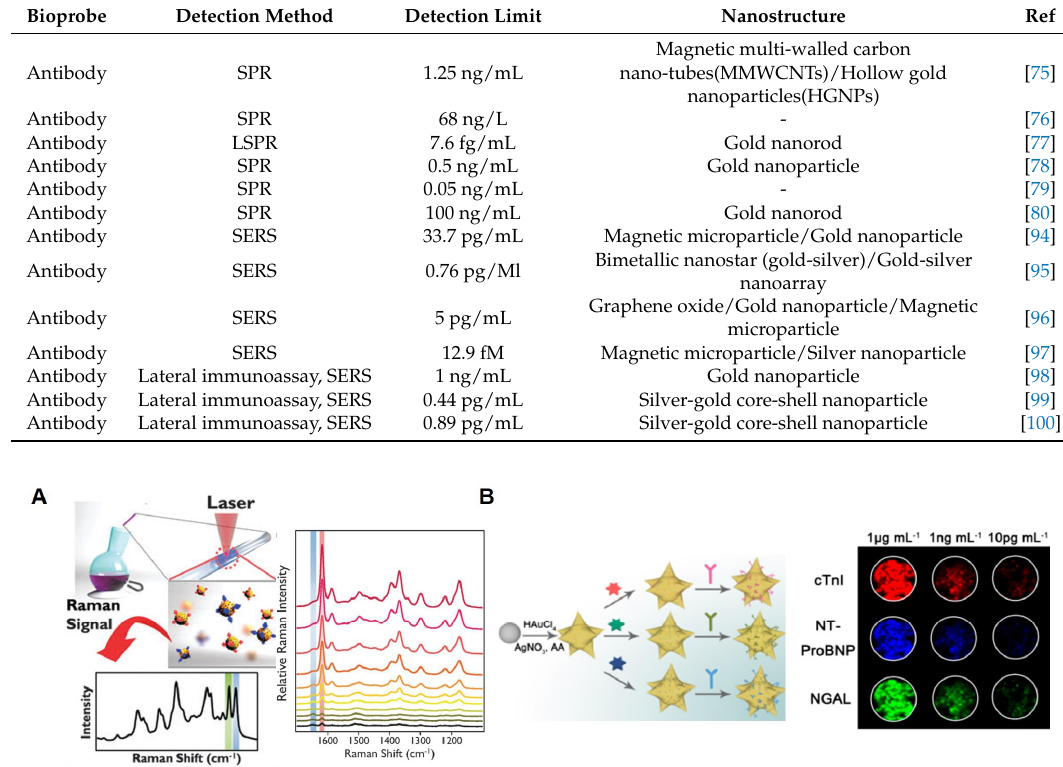
Figure 4. SERS‐based immunoassay biosensors using nanoparticles for sensitive detection. ( A ) Competitive immunoassay of TN and CK‐MB markers using magnetic microparticles and gold nanoparticles. Reproduced with permission from [96]. Copyright 2014, Royal Society of